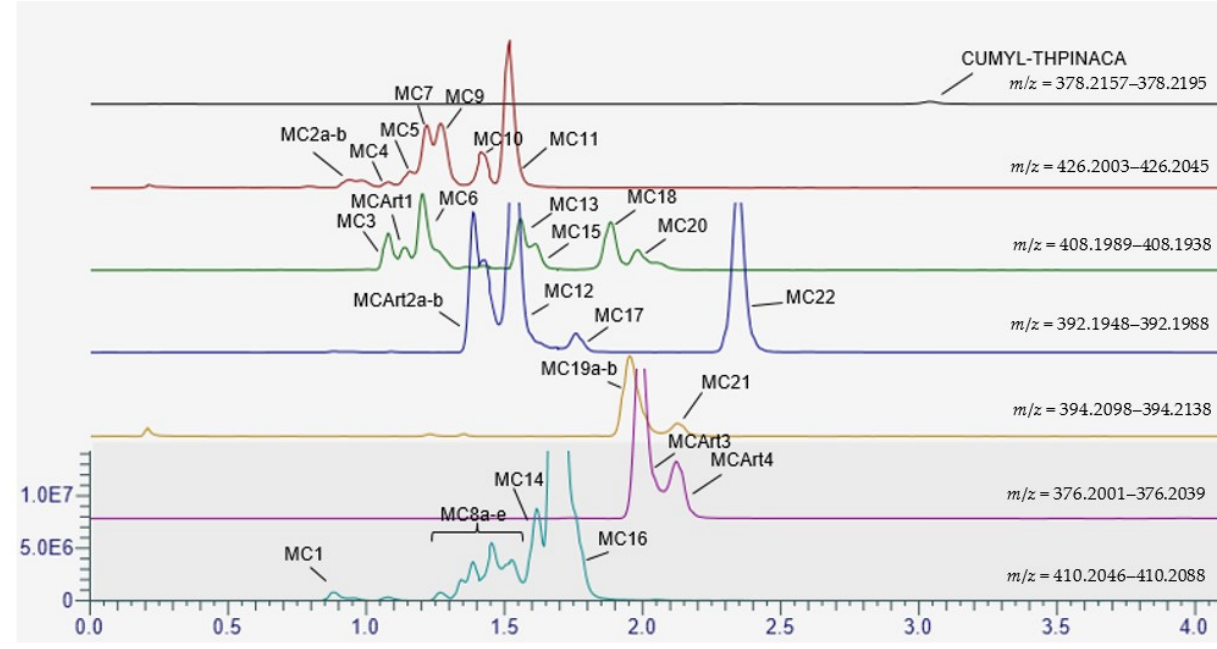
Metabolites 2021 , 11 , x FOR PEER REVIEW Figure 1. Chromatogram showing the mass traces of the detected metabolites (and artefacts) of CUMYL-THPINACA after 2 h of incubation. The traces are normalized globally, with a maximum at 12% of the base peak (MC16).